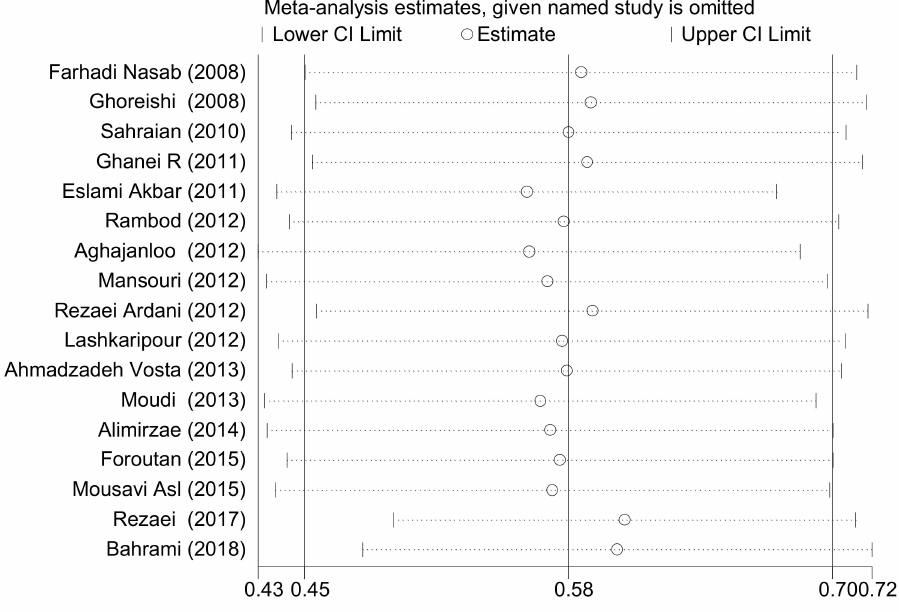
Figure 3. Sensitivity analysis showing the stability and reliability of the findings. The dotted line refers to the width of the 95% confidence interval.